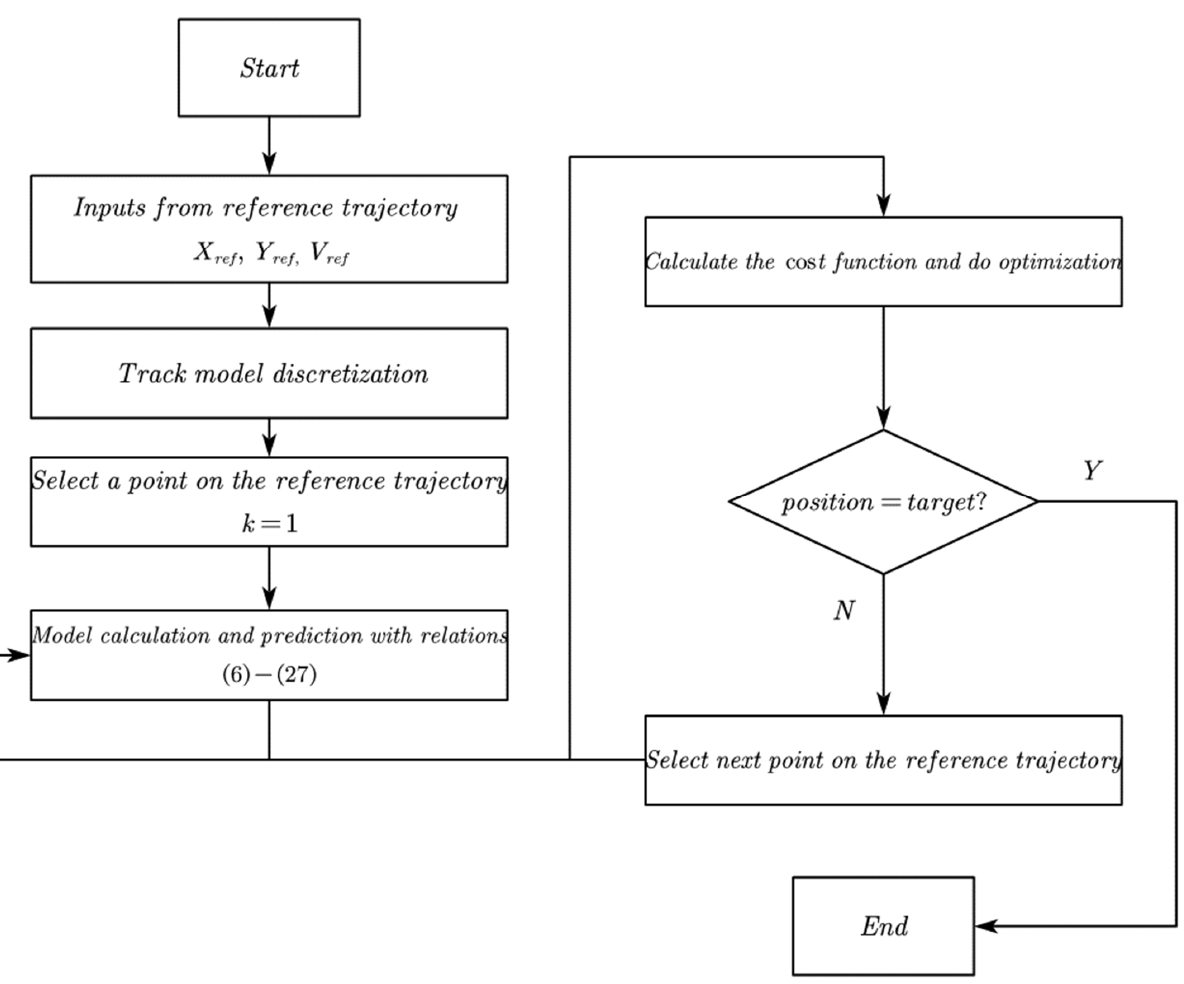
Figure 2. The flowchart of MPC tracking system steps.